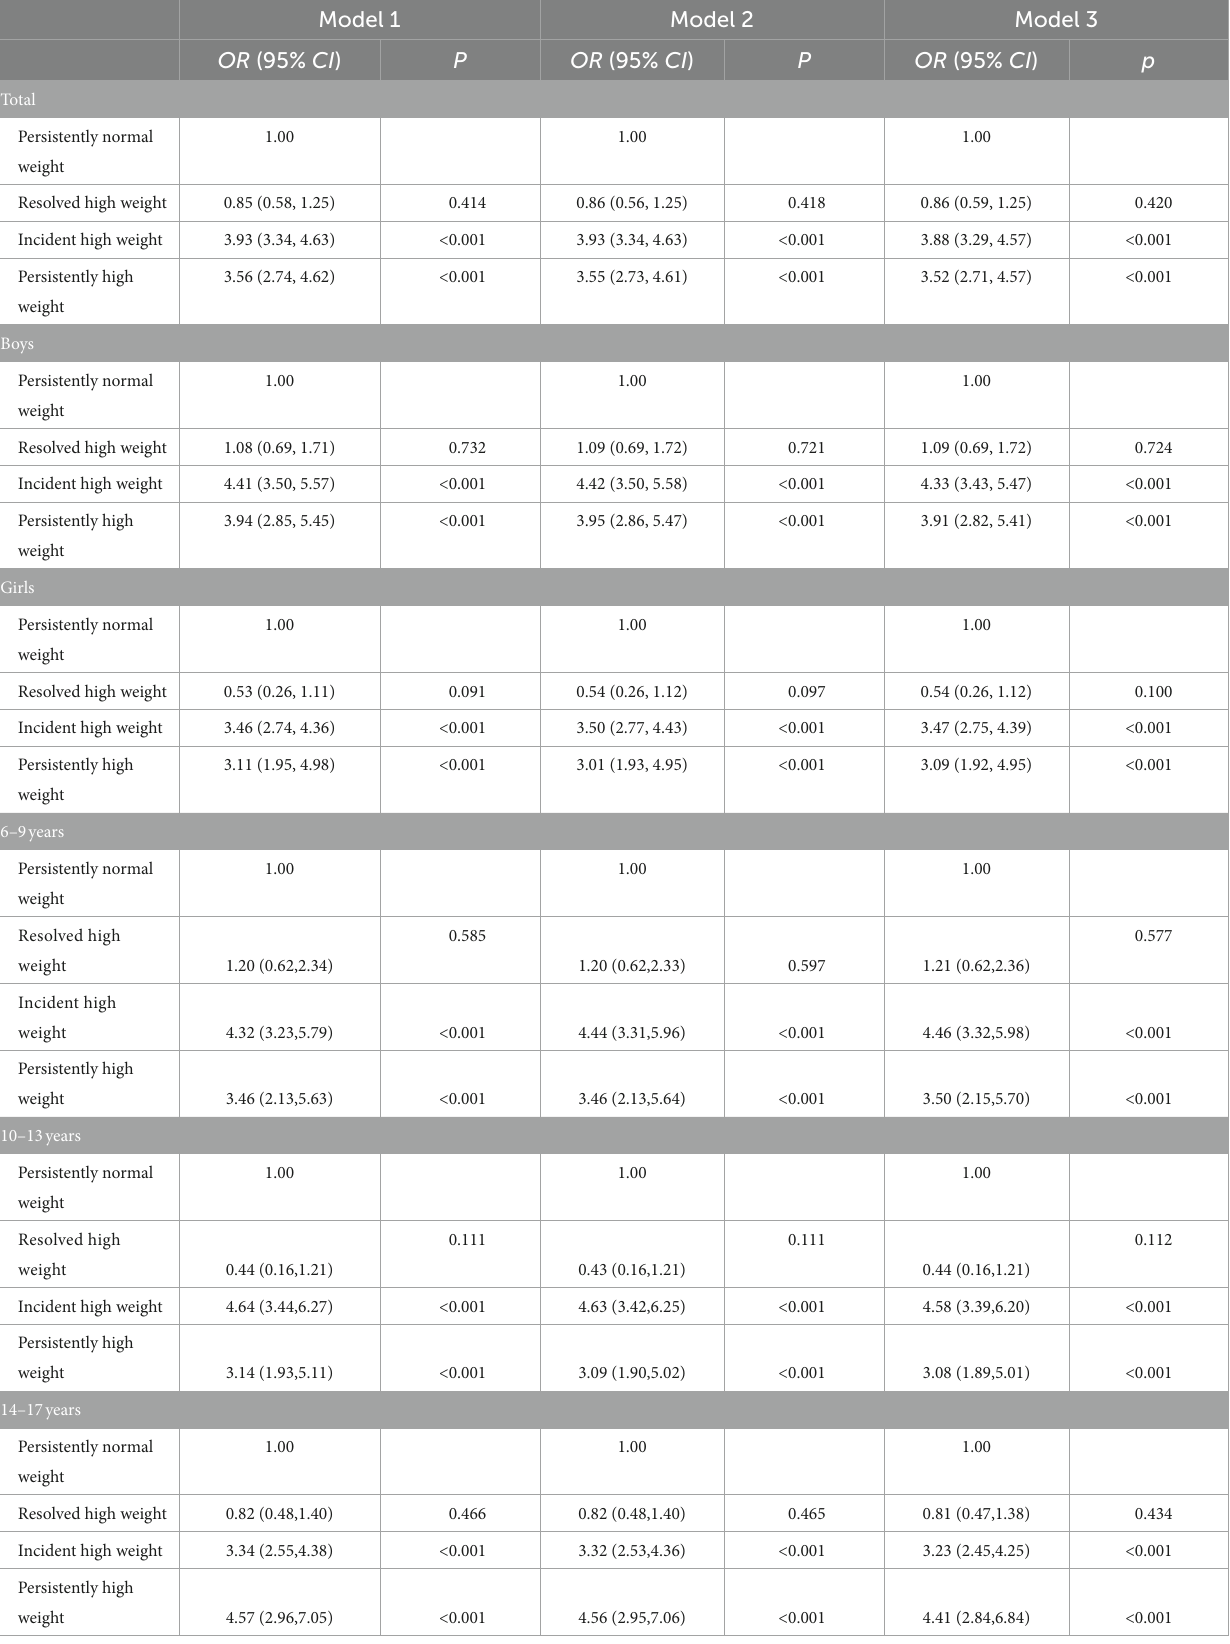
TABLE 4 Association between weight status change from birth to childhood and high blood pressure among